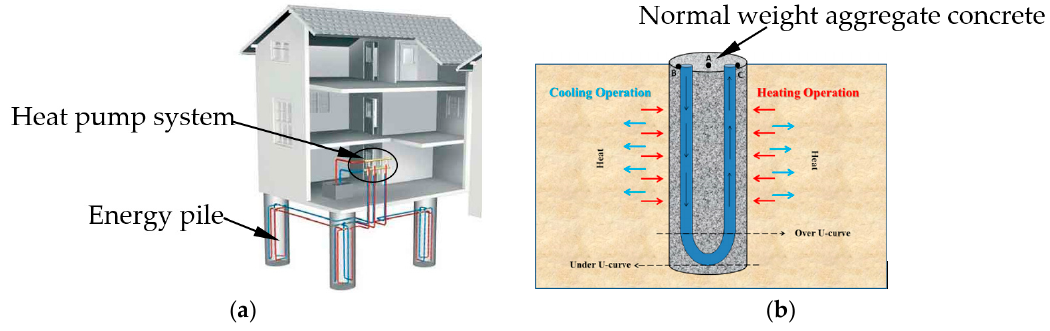
Figure 1. Energy pile application in building energy efficiency. ( a ) Schematic drawing of geothermal piles system [14]; ( b ) Heating/cooling operation of energy piles during summer/winter modes [15].